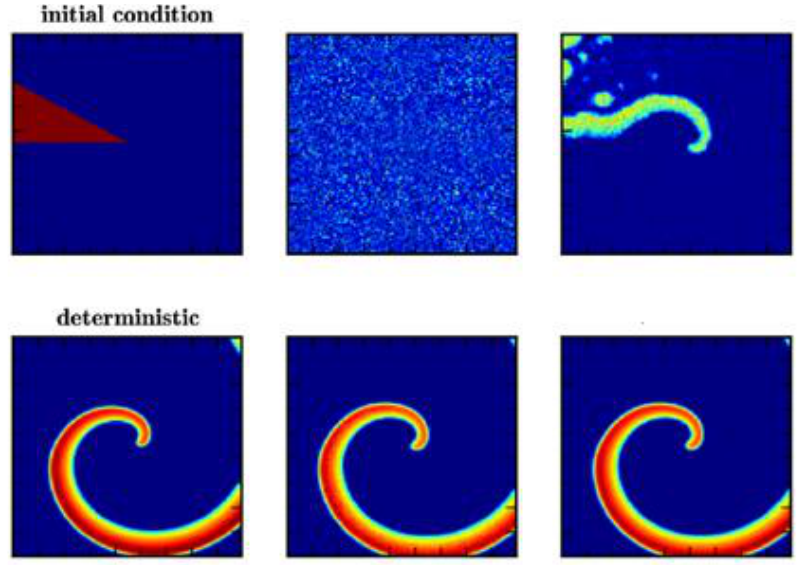
Figure 8. Spiral waves obtained when the point dynamics of the RD media of the Oregonator MCNN model are applied to the memristor array.